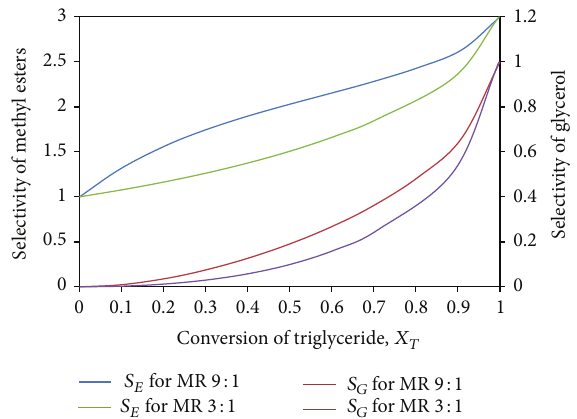
Figure6:Selectivityofmethylesteratvariousmolarratios,constant temperature of 65 ∘ C, and catalyst concentration of 1.5wt.% for Case 2.